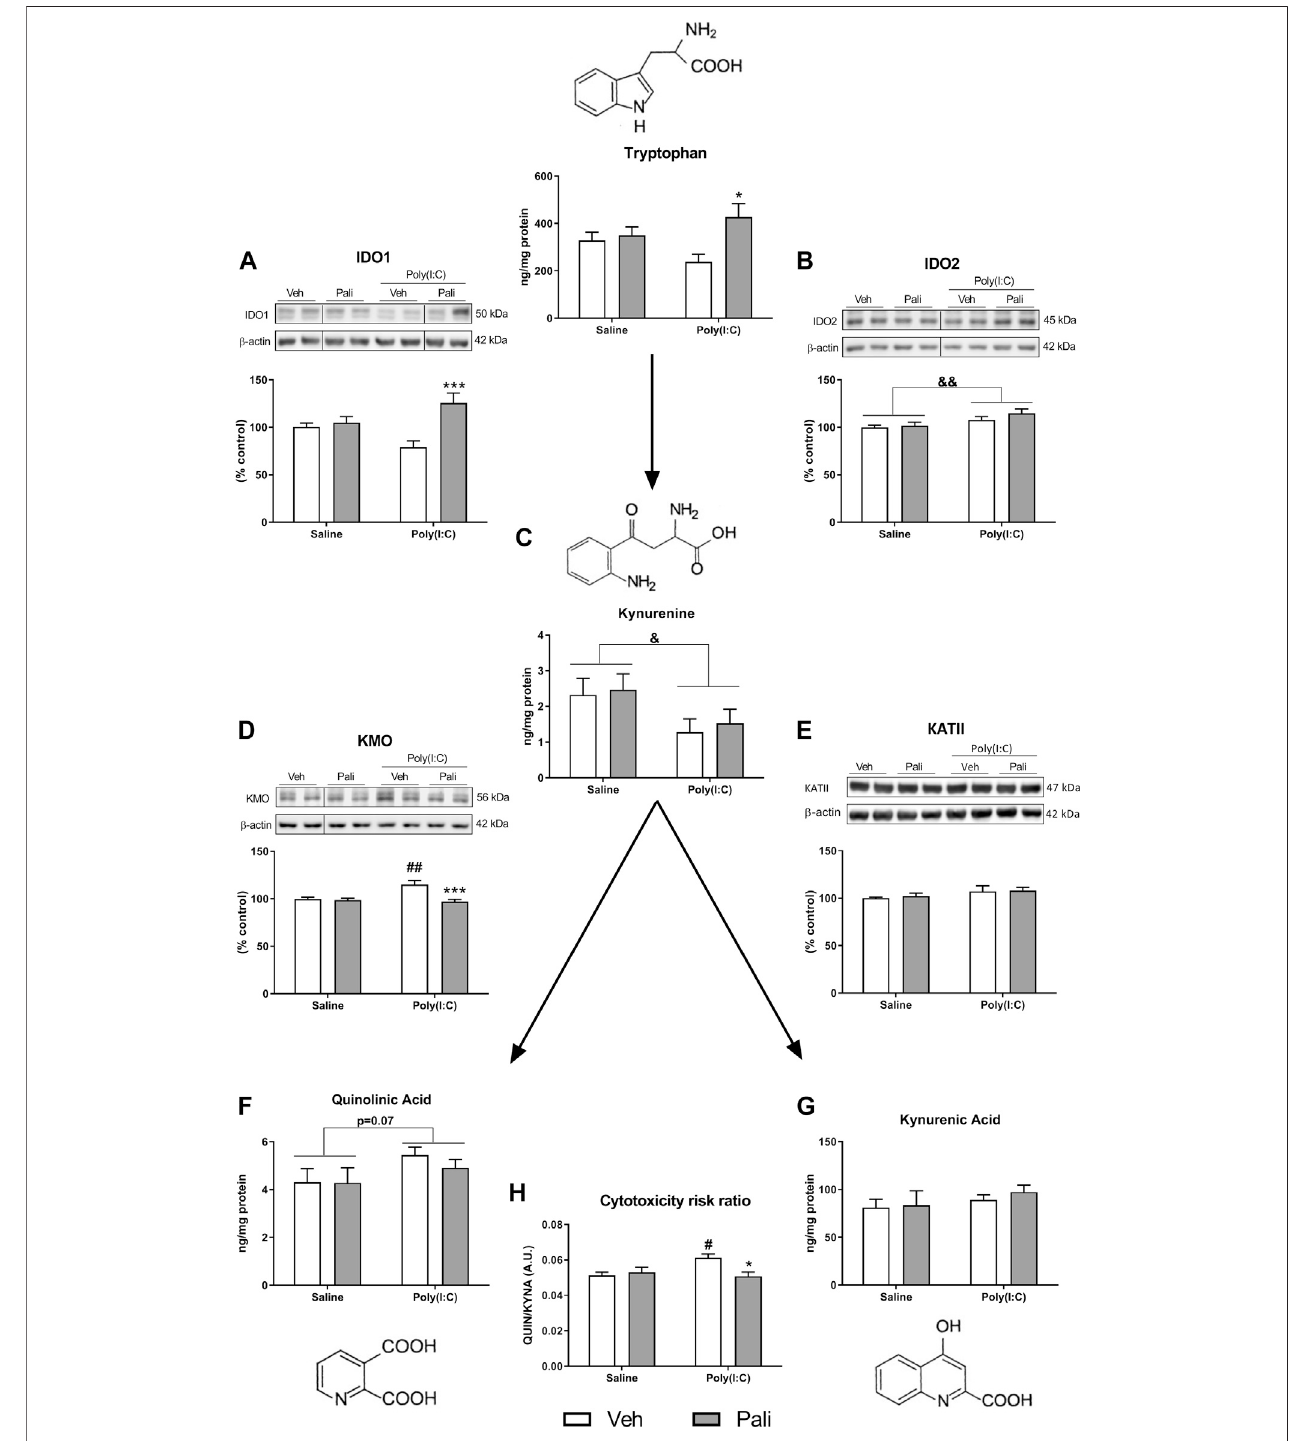
FIGURE 2 | Effects of paliperidone on kynurenine metabolic pathways after MIA in mice FC. Protein expression of IDO1 and IDO2 (A,B) , kynurenine levels (C) , proteinexpressionofKMOandKATII (D,E) ,QUINlevels (F) ,KYNAlevels (G) andcytotoxicityriskratio (H) intheFCofmicetreatedwithvehicle(Veh)orpaliperidone(Pali) in control (Saline) and prenatal poly (I:C) administration. The densitometric data of the respective immunoreactive bands were normalized by β -actin. In the (A,B,D) panels, blots werecropped (black lines)forimprovingtheclarity andconciseness ofthepresentation.Barsrepresentmeans ± SEM. Thenumber ofexperiments in all parameters analyzed was between 8-9 animals.Two-way ANOVA: & p < 0.05 and && p < 0.01 for poly(I:C) factor. # p < 0.05, ## p < 0.01 vs saline+Veh group; * p < 0.05, *** p < 0.001 vs poly (I:C)+Veh group (Bonferroni post hoc test after signi fi cant interaction).